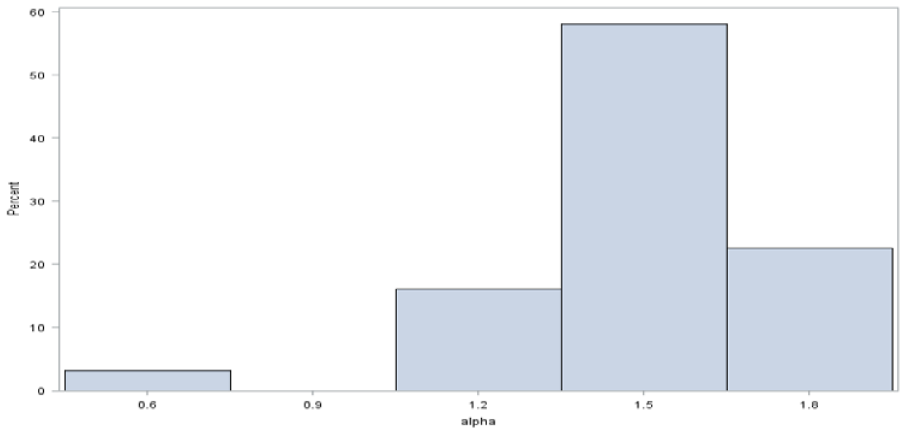
Figure 1 : Distribution of the stability index α for log-returns distribution of the selected assets